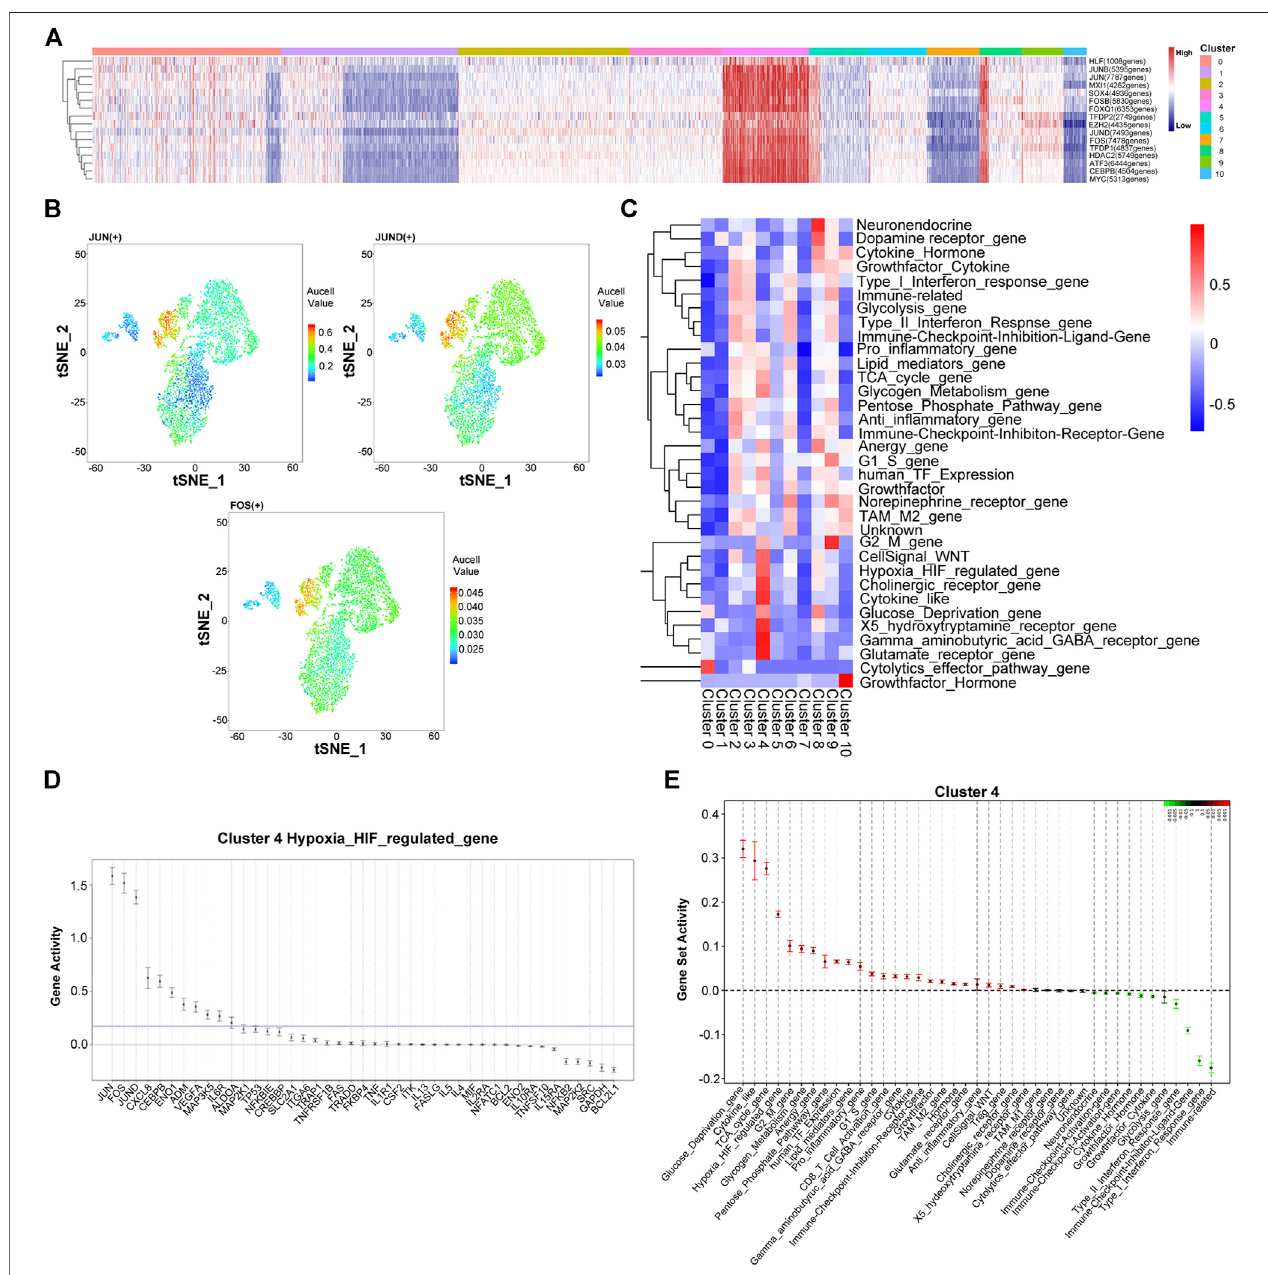
FIGURE 3 | Heterogeneity of gene expression and metabolic pathways in sorafenib poor response cell in the PR-SA group. (A) Heatmap showed activation intensity of the genes in tSNE-assigned cell clusters. Red means genes were activated, blue means genes were inhibited. (B) Transcription factor JUN, JUND, FOS activation degree in the PR-SA group. The color represents the degree of gene activation. (C) QuSAQE analysis of metabolic activities. Red means metabolic was activated, blue means metabolic was inhibited. (D) Hypoxia metabolism regulated gene activity strength in cluster 4. (E) Gene set activity strength in cluster 4. Red means gene set was activated, blue means gene set was